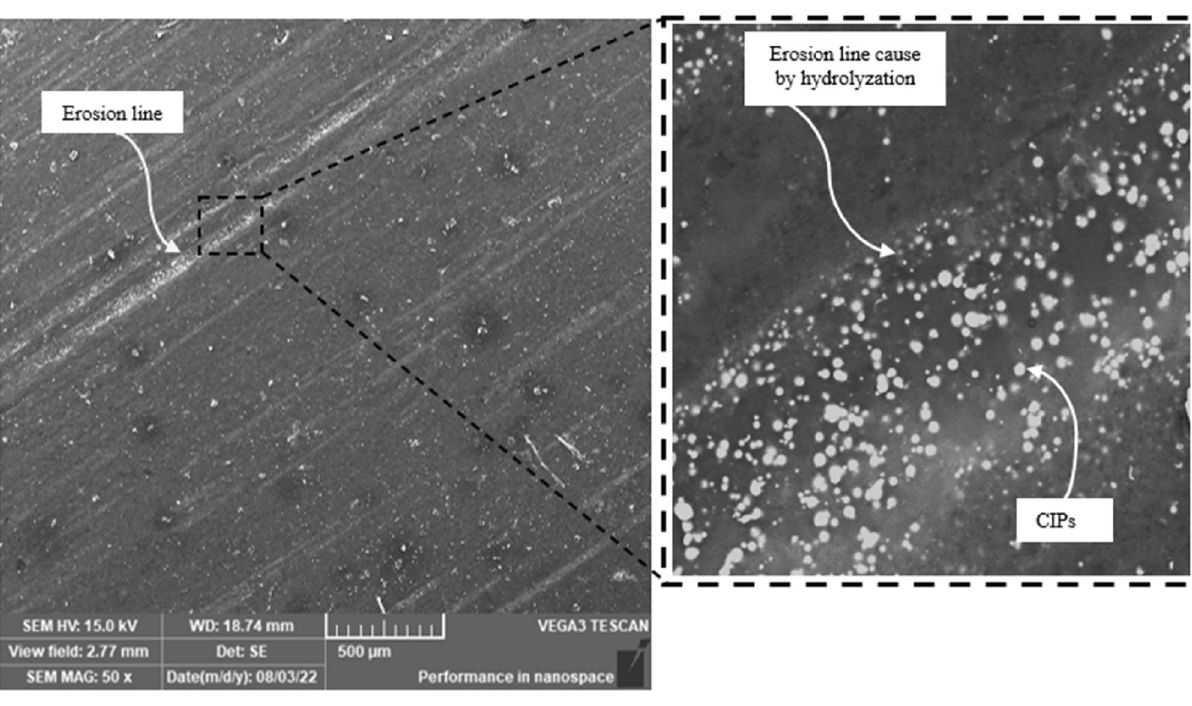
Figure 2. Surface morphology of MRE samples after 30 days of immersion in salt water with magnification picture inside the small